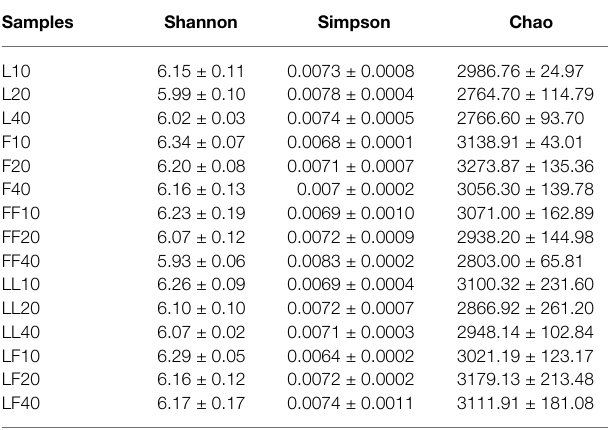
TABLE 2 | Diversity indices of soil bacterial communities in OUT